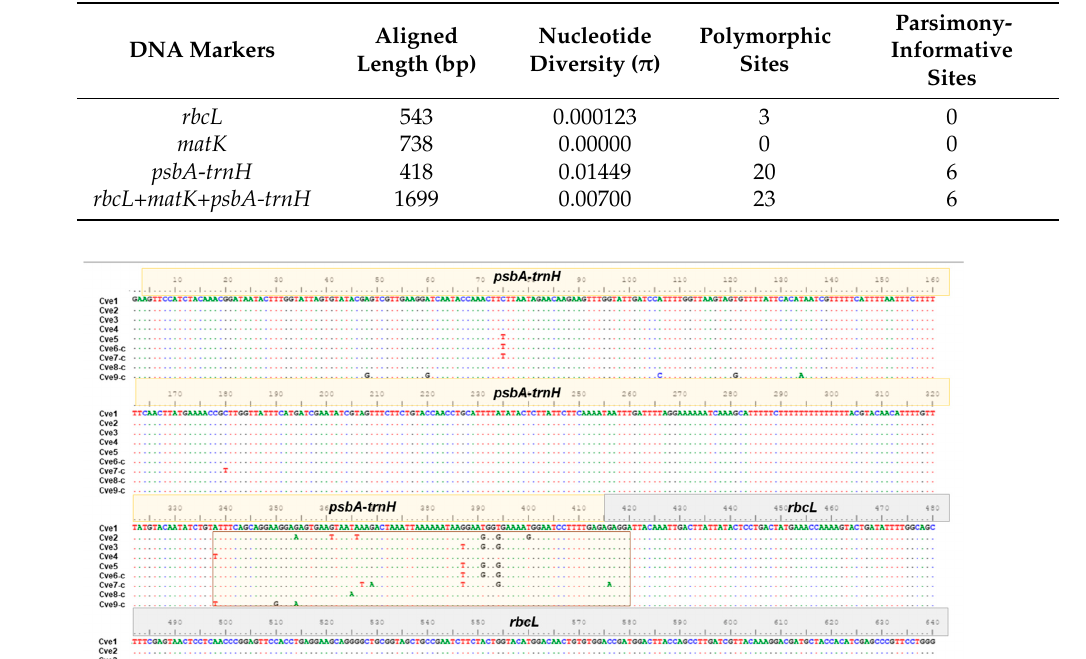
Table 2. Molecular characteristics of markers evaluated for Cinnamomum verum .